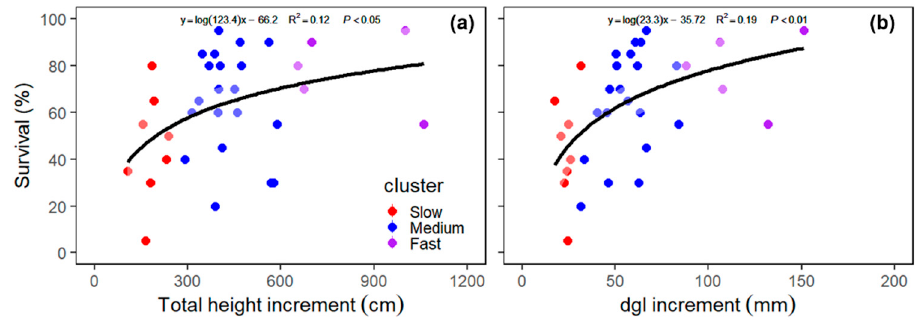
Figure 7. Relationship between survival percentage and ( a ) total height and ( b ) dgl increments at age 5 years. Each colored symbol represents the species of each cluster (slow, medium, and fast).